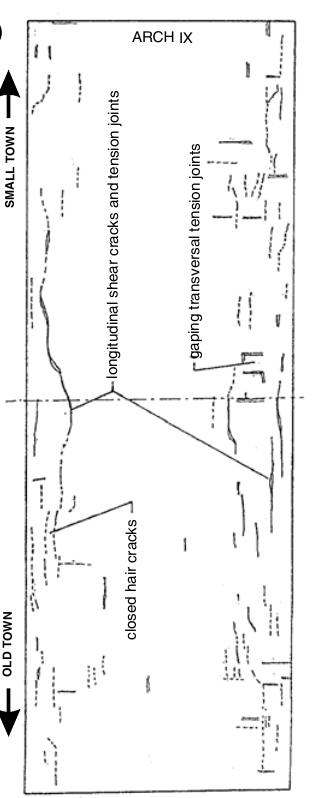
Fig 13. Temperature time pattern in reinforced concrete slab in the crown in spring (initial slab temperature +3 o C, average day temperature 12 o C with amplitude of 6 o C) (a); ditto 1/3 of arch span (b); reference temperature field 1/3 of arch span – spring, 6 th day after temperature rise) (c); surface temperatures of stone bridge structure (t max = 25,1 °C, t min = 16,8 °C; thermovision – May 2003) (d)